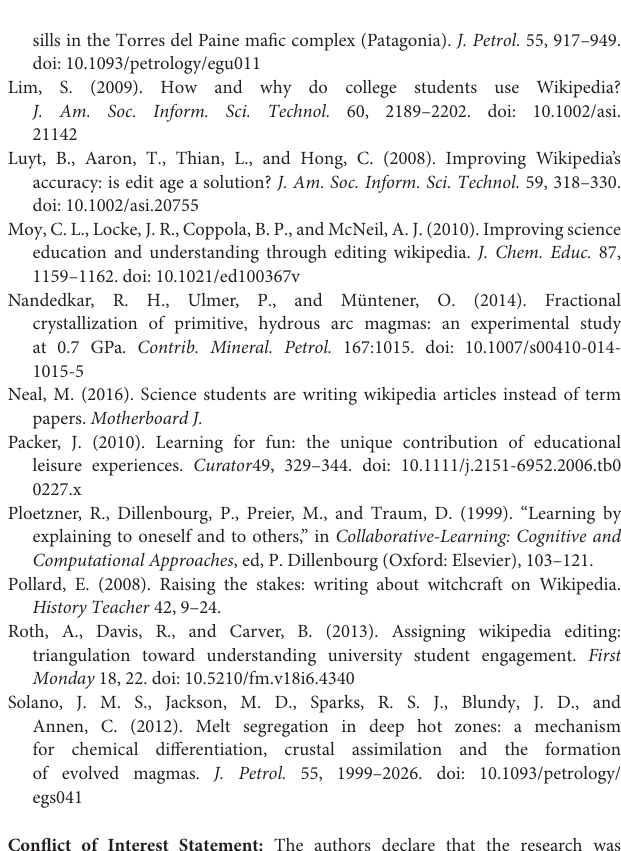
Table S1 | Articles used in this course. Table S2 | The Wikipedia grading scheme (as on the 21st of December 2017). Table S3 | The Wikipedia page creation assessment